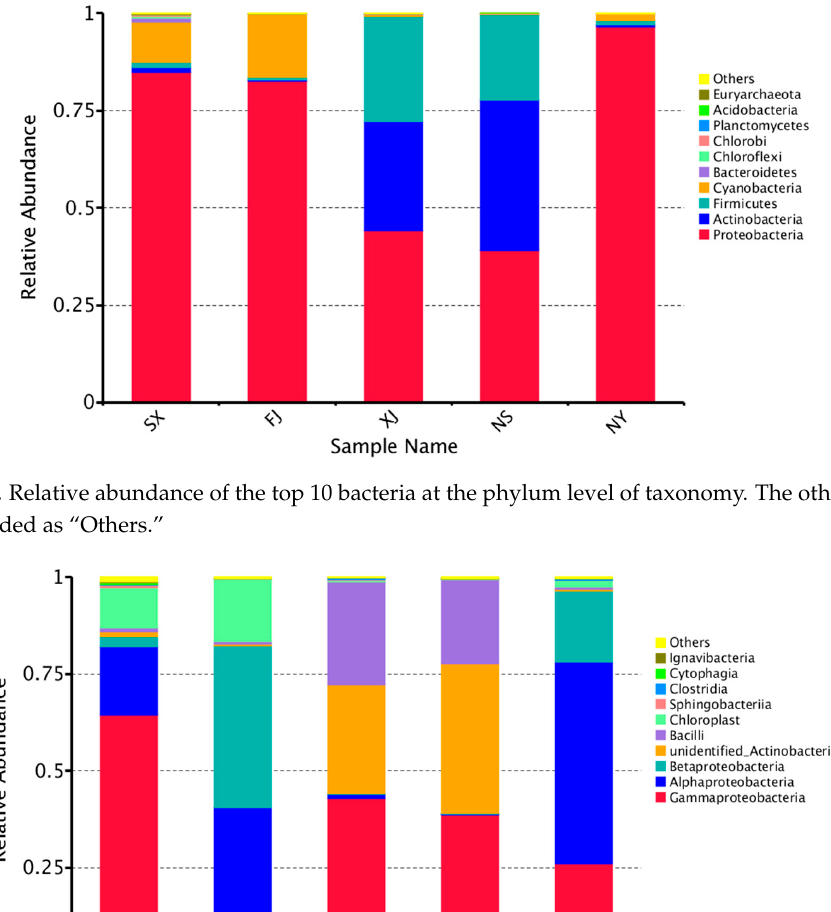
Figure 1. Operational taxonomic unit (OTU) clustering and annotation statistics of each sample.